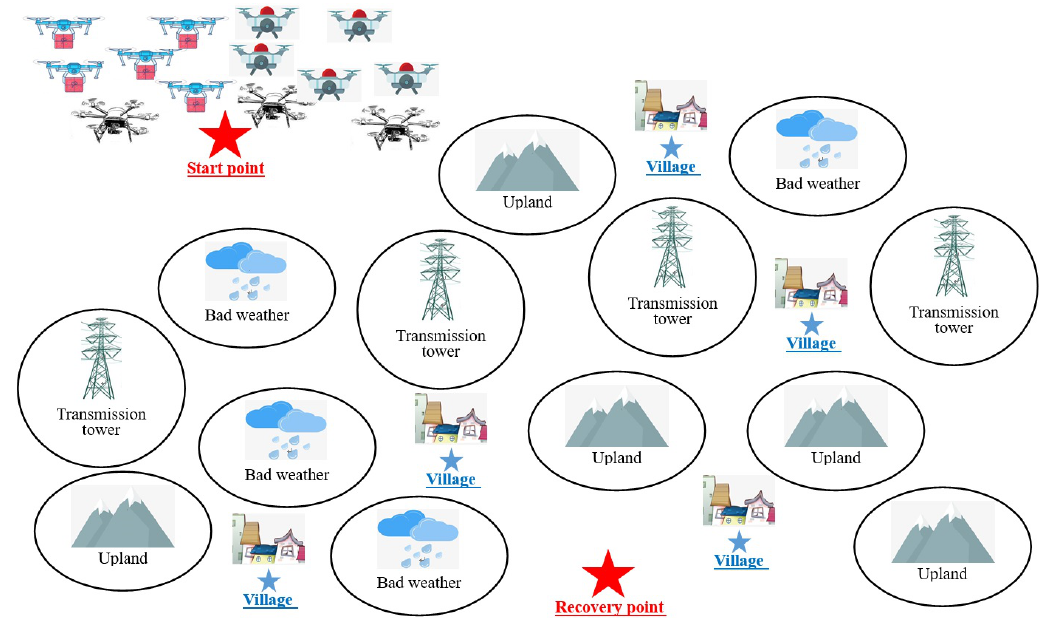
Figure 1. Sketch map of multi-UAV-based disaster rescue.